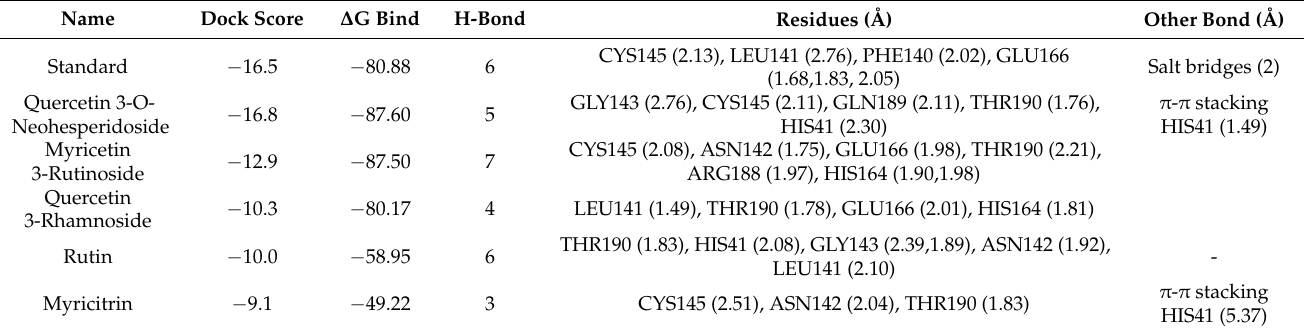
Table 3. Binding energies of flavonoids docked against M pro